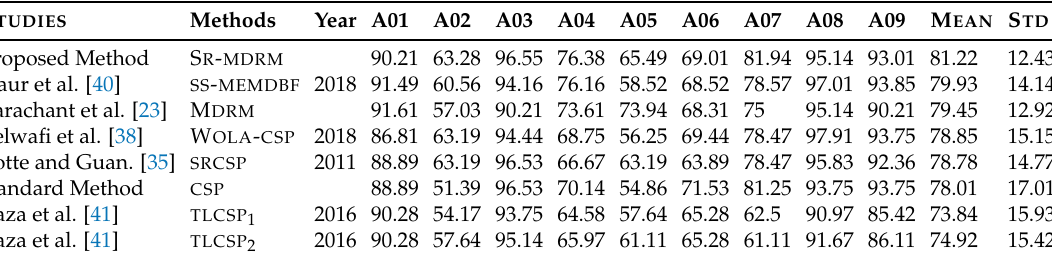
Table 6. Classification accuracy (mean and standard deviation in percent) of the proposed approach and other approaches on Dataset IIa, BCIC